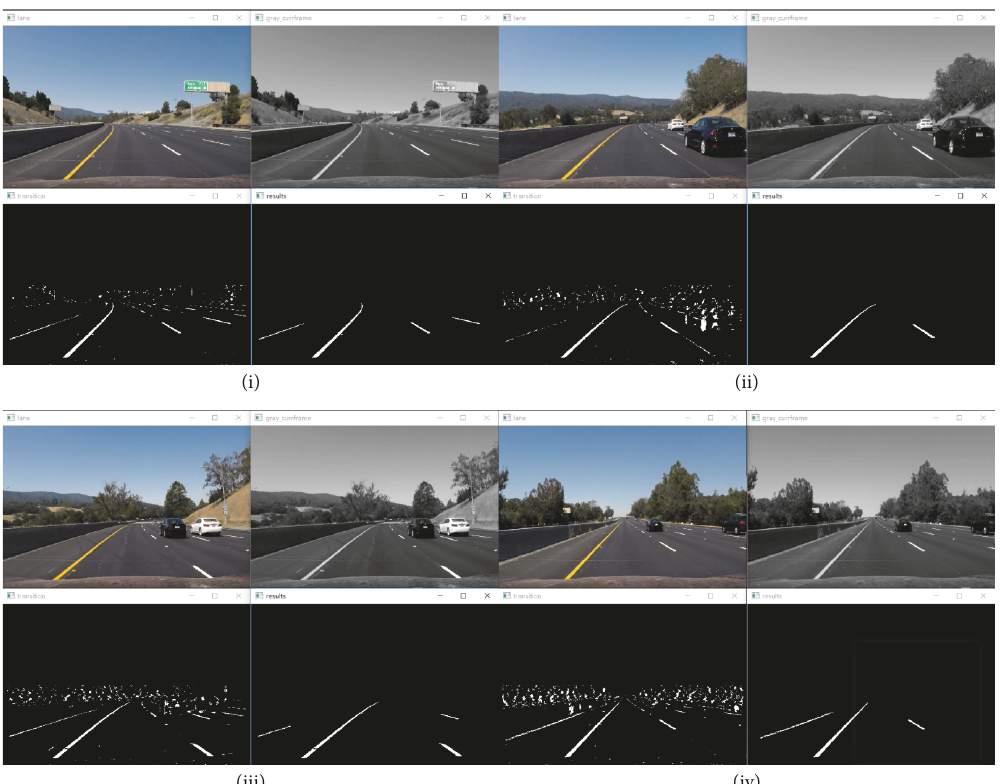
Figure 14: Different moments (i), (ii), (iii), and (iv) in another video.